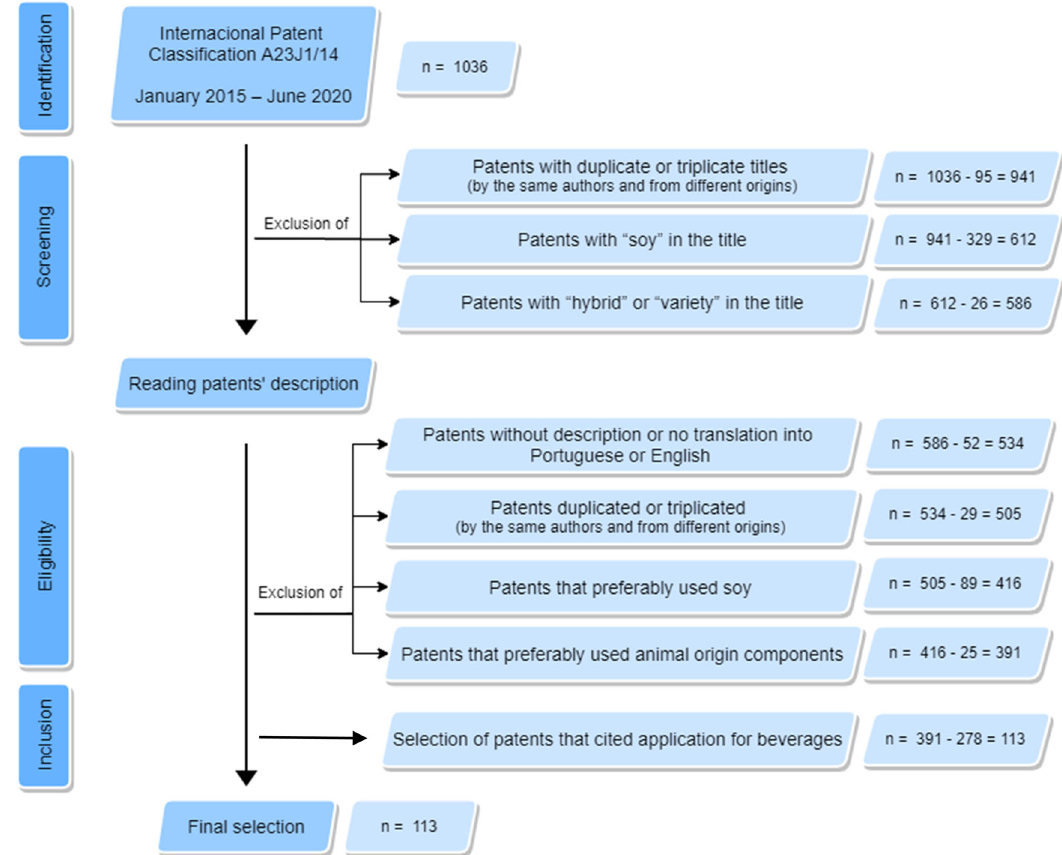
Fig. 2 Research methodology fl owchart. Patents ’ identi fi cation followed by screening, and eligibility and inclusion criteria application.